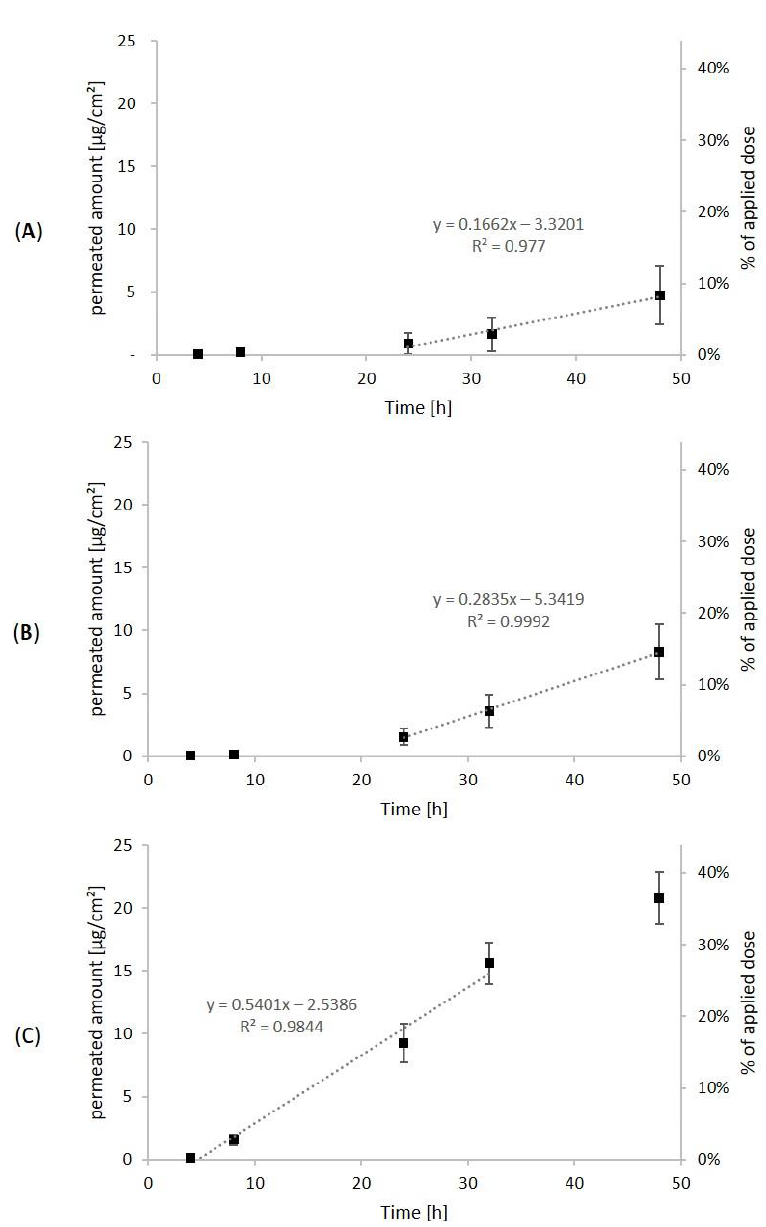
Figure 2. Cumulative permeated STL amount relative to skin area (left axis) and percent of total applied dose (right axis) in the receptor fluid over time (4 h to 48 h) after application of 0.5 mL Arnica tincture on porcine skin ( A ), human skin A ( B ) and human skin B ( C ), n = 6. The dashed regression line is based on the absolute permeated amounts (left axis). It represents the linear range used to calculate the steady-state flux, which is the slope of the regression line.